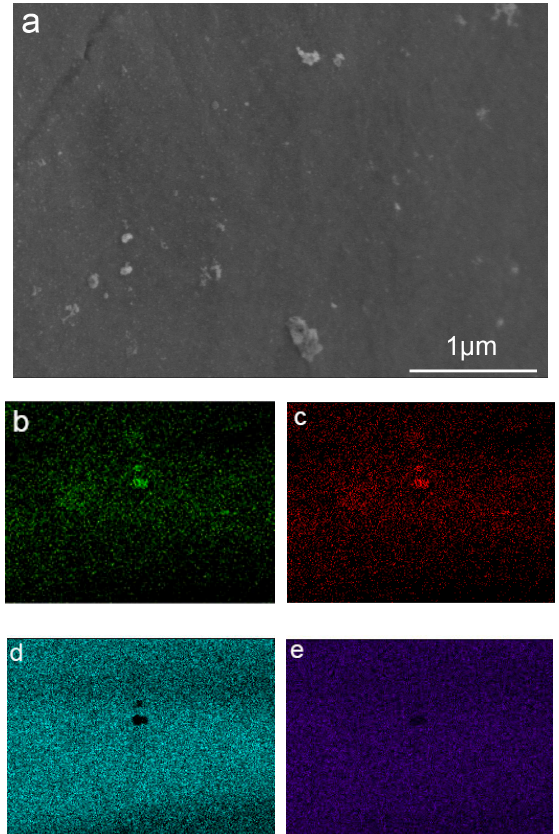
Figure 3. SEM image and element mappings of precipitates on the surface of the 3D printed samples